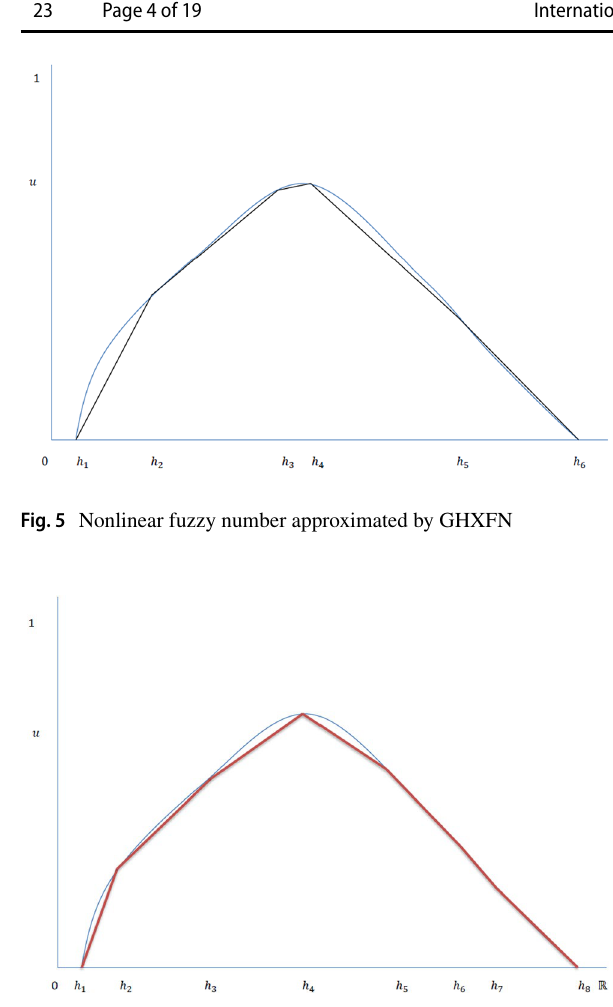
Fig. 6 Nonlinear fuzzy number approximated by